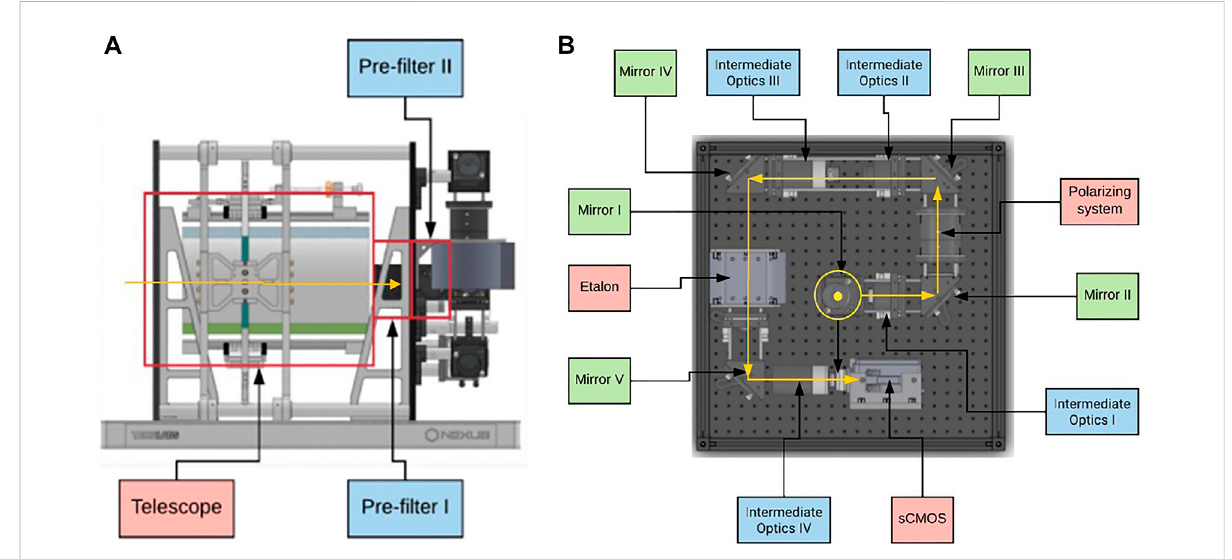
FIGURE 1 Mechanical model of the spectropolarimeter ’ s proof-of-concept. (A) represents the side view and (B) is the front view. Yellow arrows indicate the path of light on both panels. The light enters the telescope and then passes through the other components in the optical path after passing through the pre- fi